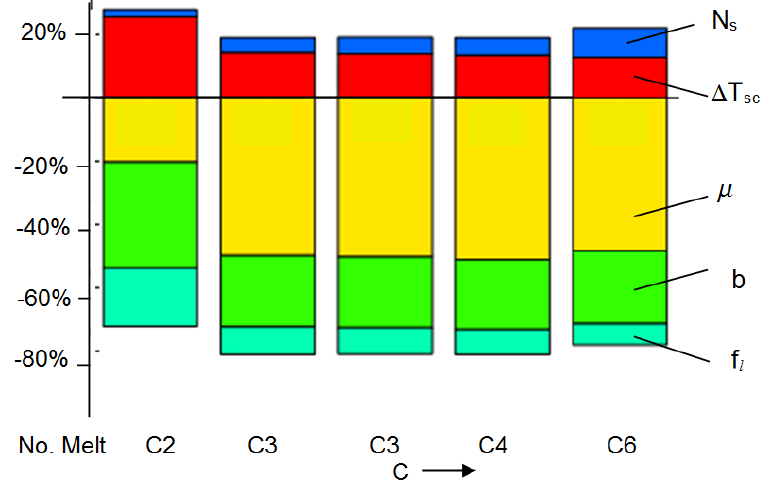
Figure 12. Carbon intensity effect on the CT index through f l , μ,  T sc , N s and b (− CT decreases; + CT